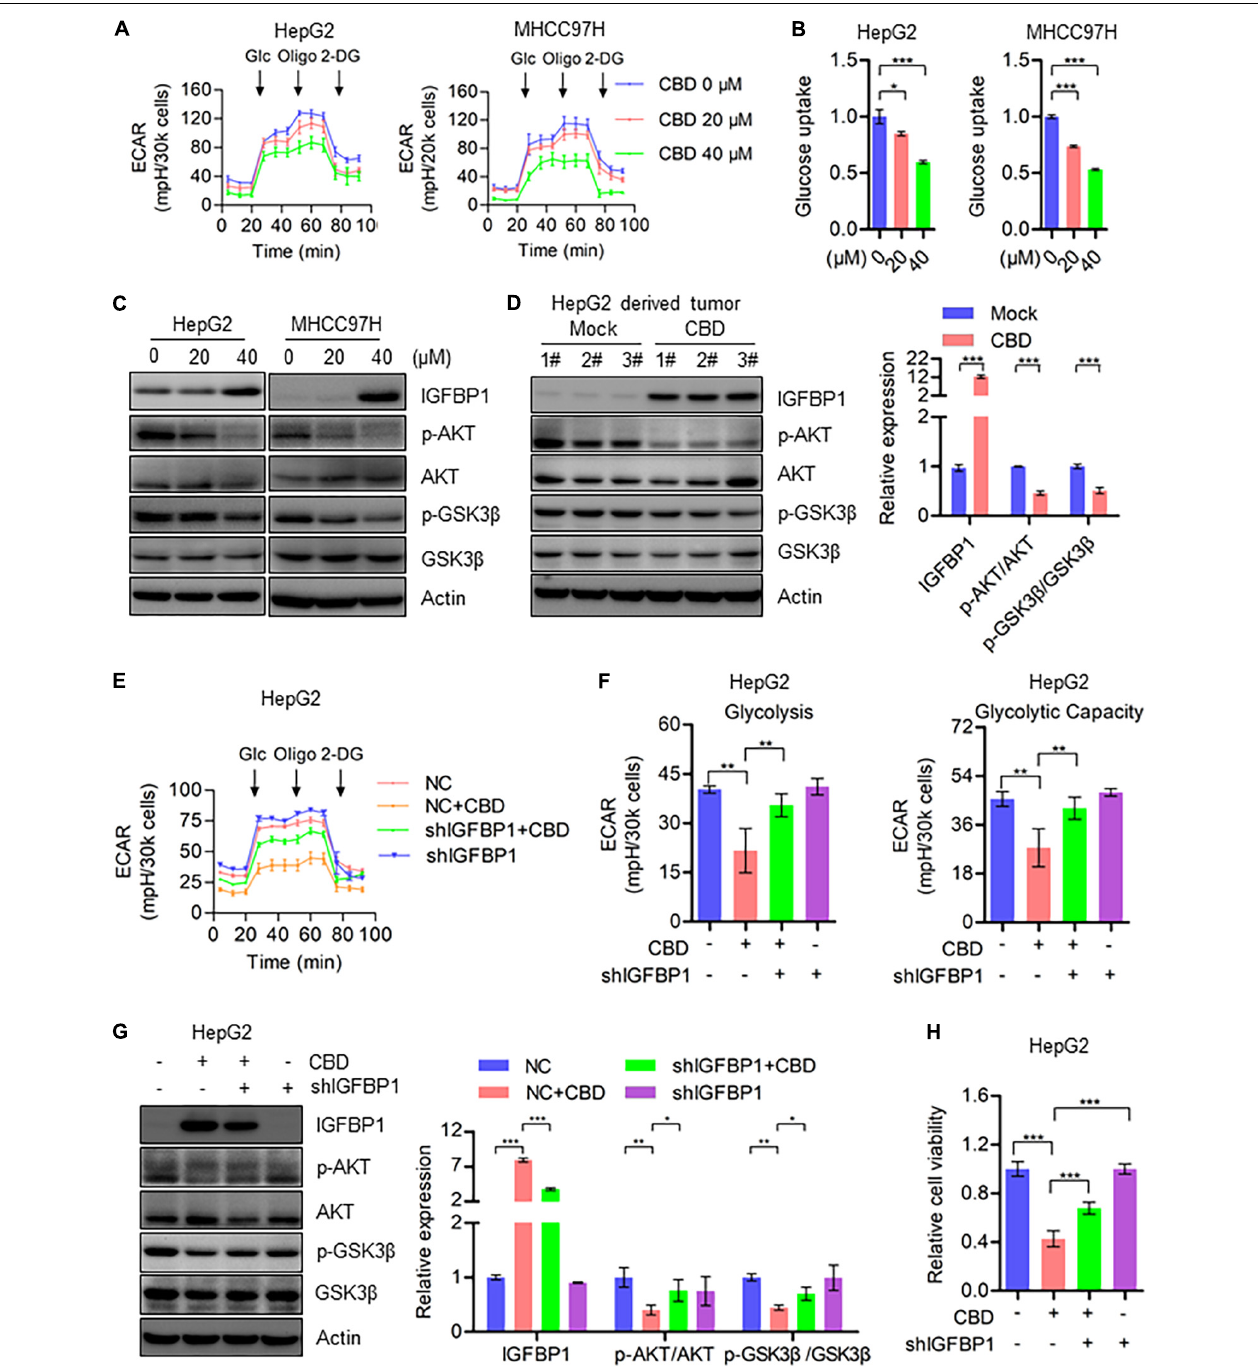
FIGURE 6 | CBD inhibits cell glycolysis through repressing AKT/GSK3 β axis. (A) Extracellular acidification rate (ECAR) of CBD treated HepG2 and MHCC97H cells in the indicated conditions was measured in real time using the Seahorse XF96 Extracellular Flux Analyzer. Basal ECAR was measured at three time points, followed by sequential injection of glucose (10 mM), oligomycin (1 µ M), and 2-DG (100 mM). Data are presented as mean ± SD. (B) Glucose uptake was detected by 2-NBDG staining in CBD-treated HepG2, HUH7, and MHCC97H cells. (C) Western blot analysis of IGFBP1, p-AKT, AKT, p-GSK3 β , and GSK3 β in CBD treated HepG2 and MHCC97H cells after 24 h. Actin was used as a loading control. (D) Western blot analysis of IGFBP1, p-AKT, AKT, p-GSK3 β , and GSK3 β in CBD administrated tumor tissues derived from HepG2 cells. Actin was used as a loading control. The graphs represent the mean ± SEM. (E,F) Extracellular acidification rate (ECAR) was measured in control and IGFBP1 knockdown HepG2 and MHCC97H cells after CBD exposure. (G) Western blotting analysis of IGFBP1, p-AKT, AKT, p-GSK3 β , and GSK3 β in control and IGFBP1 knockdown HepG2 cells after CBD (40 µ M) administration for 24 h. (H) Cell viability was determined in control and IGFBP1 depletion HepG2 cells in the presence of CBD for 24 h. The meaning of ‘*‘ is statistically significant. * p < 0.05, ** p < 0.01, *** p < 0.001.